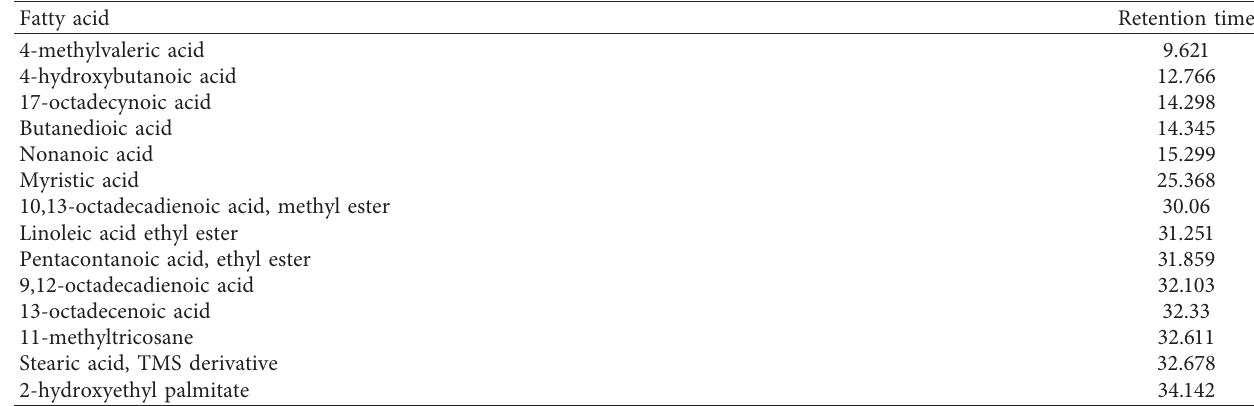
Table 3: Fatty acids identified in Juglans regia .